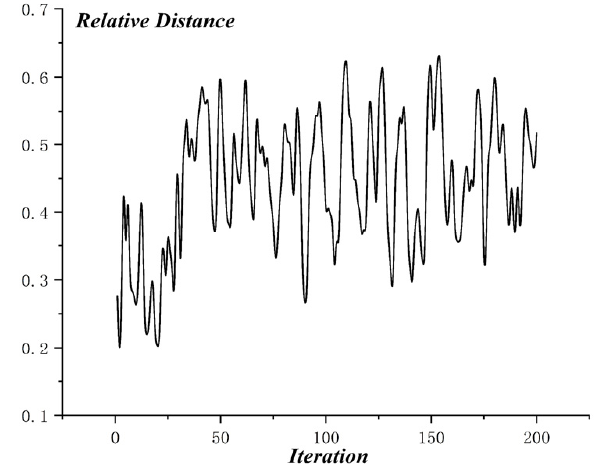
Figure 13. Relative distance of NSGA-2.